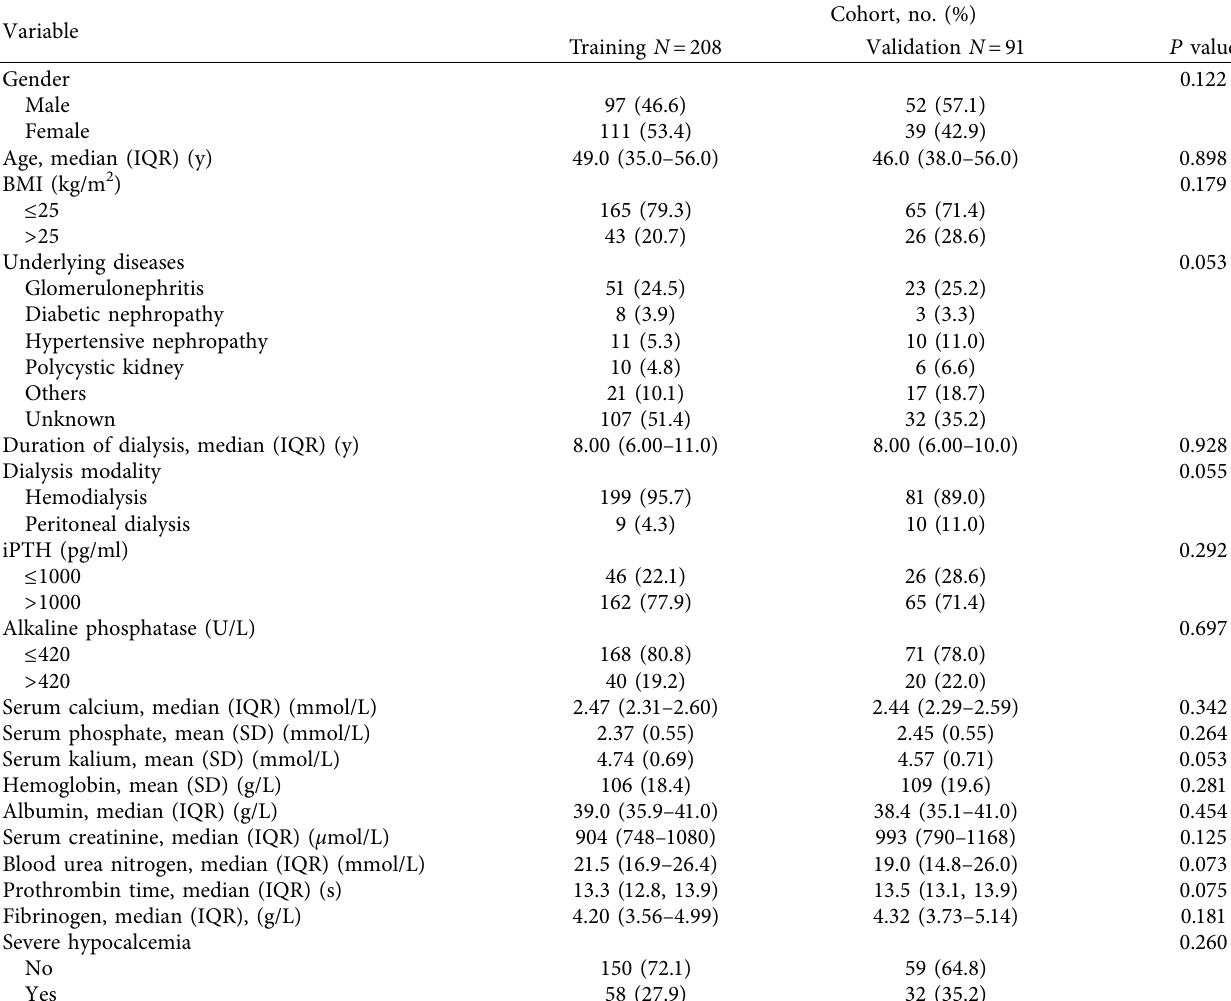
Table 1: Clinical characteristics of 299 patients undergoing